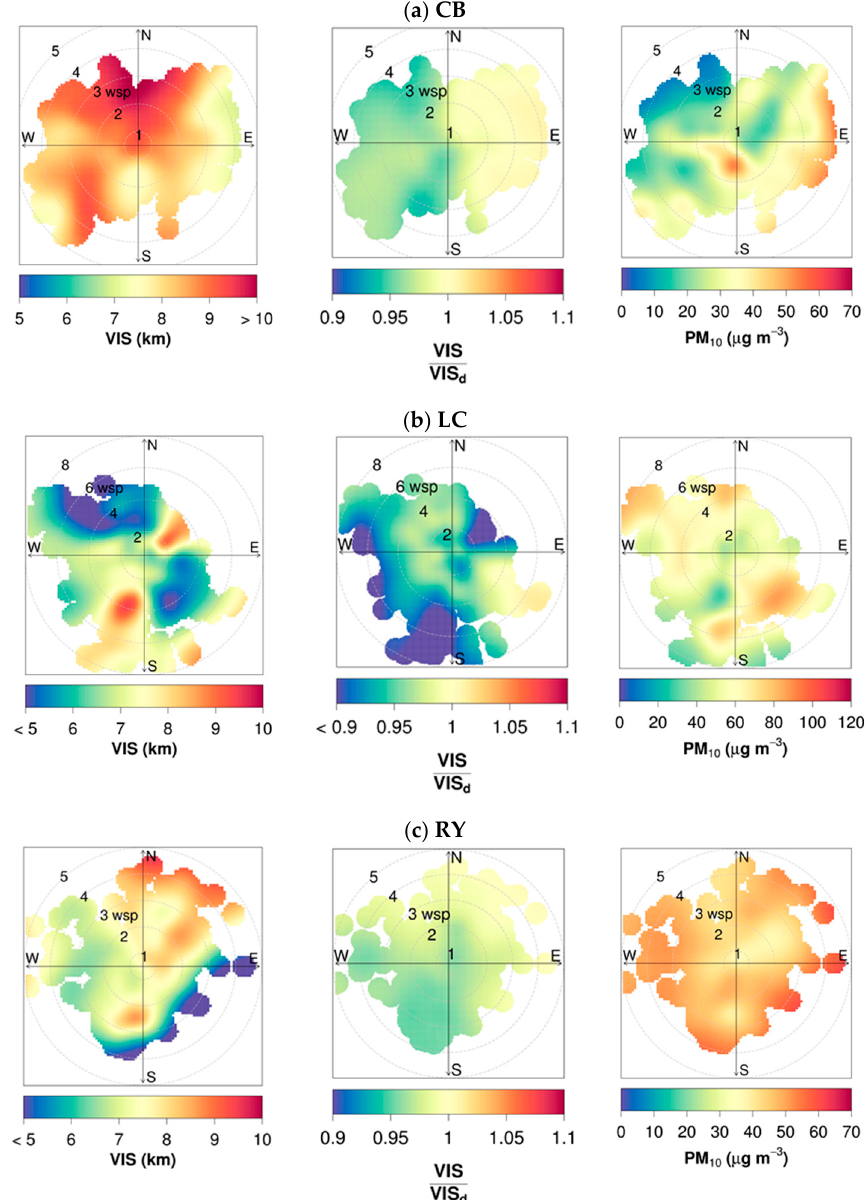
Figure 6. Polar plots of visibility ( VIS ), visibility/ RH -corrected visibility ( VIS / VIS d ), and PM 10 at ( a ) Chon Buri (CB); ( b ) Laem Chabang (LC); and ( c ) Rayong (RY). Back-trajectory modelling shows a total of five similar clusters at both stations: (1) northeasterly and high level (“NE_H”) (with occurrences of 11.3% of total days at CB and 7.9% at RY); (2) northeasterly but low level (“NE_L”) (33% at CB and 36.2% at RY); (3) southeasterly (“SE”)